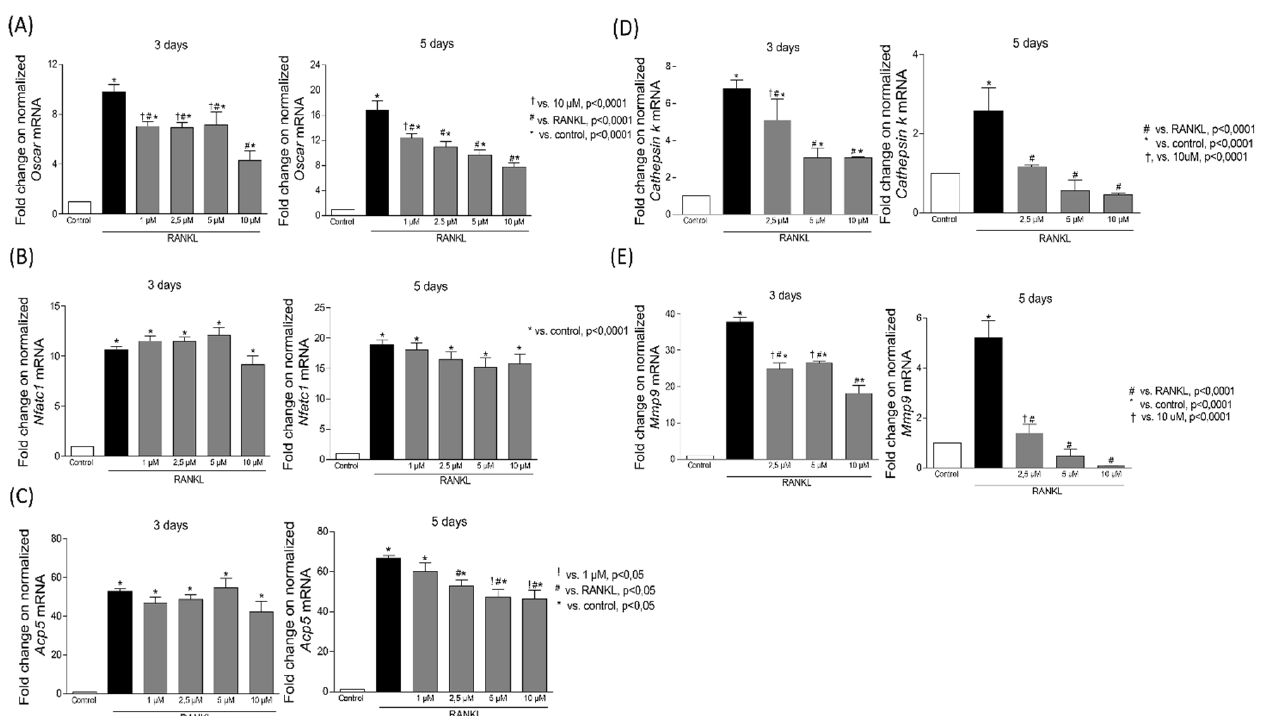
Figure 3. Chalcone T4 inhibits gene expression of bone markers in RANKL-stimulated RAW 264.7 cells. Effect of chalcone T4 on gene expression of Oscar ( A ), Nfatc1 ( B ), Acp5 ( C ), Cathepsin k ( D ) and Mmp-9 ( E ). Chalcone significantly inhibited the gene expression of Mmp-9 , Cathepsin k and Oscar on the third and fifth day after stimulation with RANKL ( p < 0.0001), and only in the later period (fifth day) the expression of Acp5 . Nfatc1 expression was not altered by Chalcone treatment. Data is presented as fold change to unstimulated (control) cells. The bars indicate the mean results and the vertical lines the standard error (SEM) of three independent experiments performed in duplicate. Statistically significant differences between groups, as well as p values are indicated in the